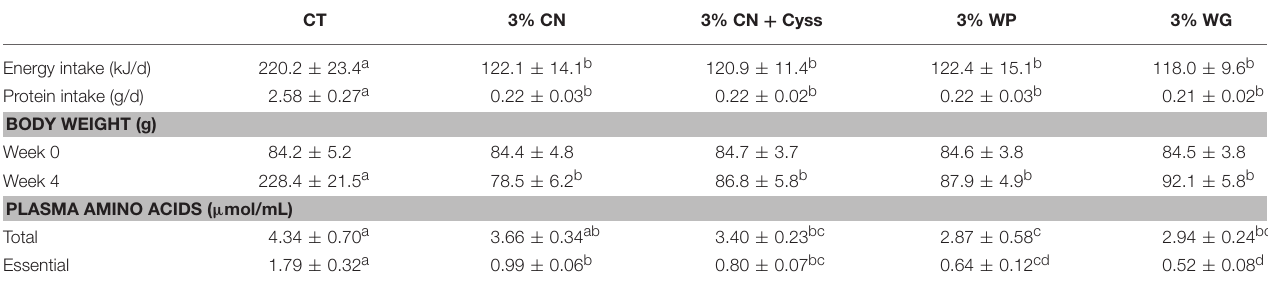
TABLE 2 | Energy intake, protein intake, body weight, and plasma free amino acid levels in Experiment 1.